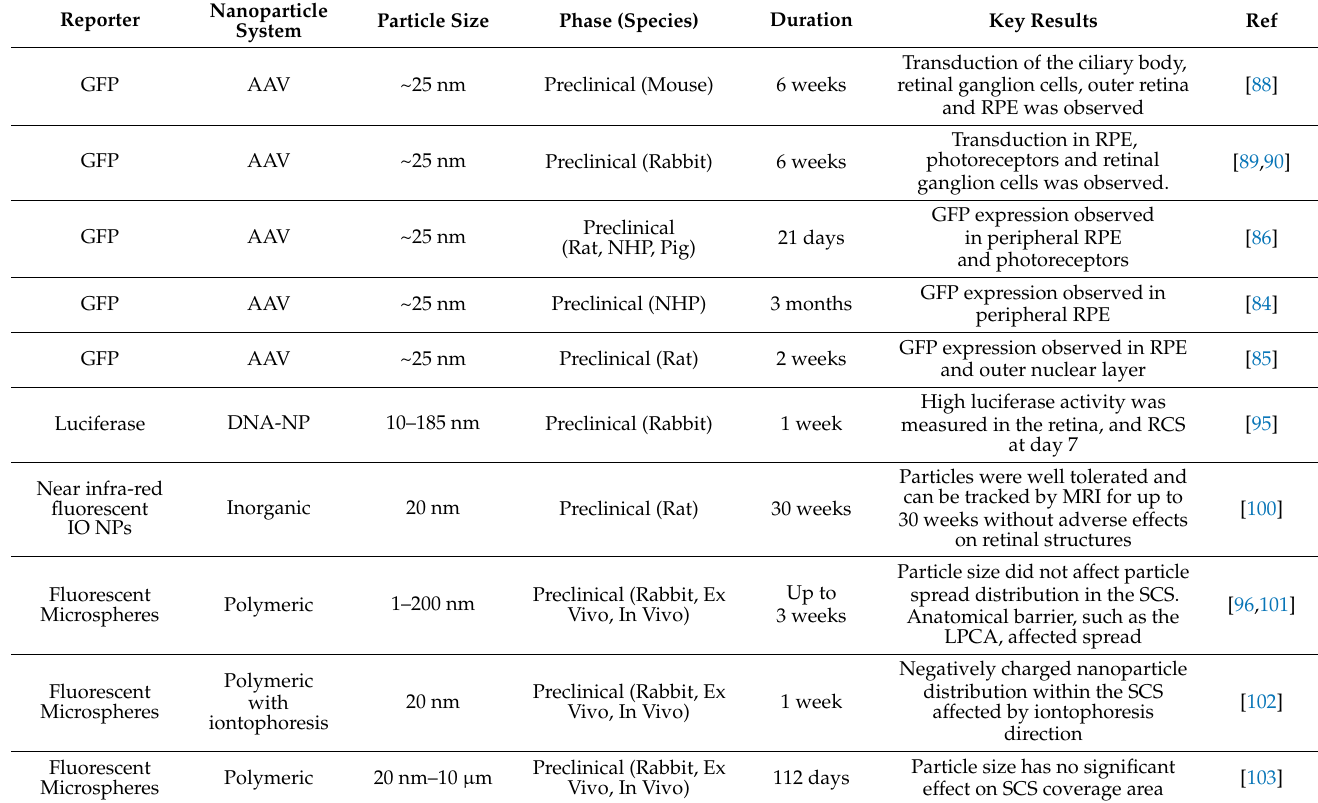
Table 4. Summary of Nanoparticle Systems Delivered into the Suprachoroidal